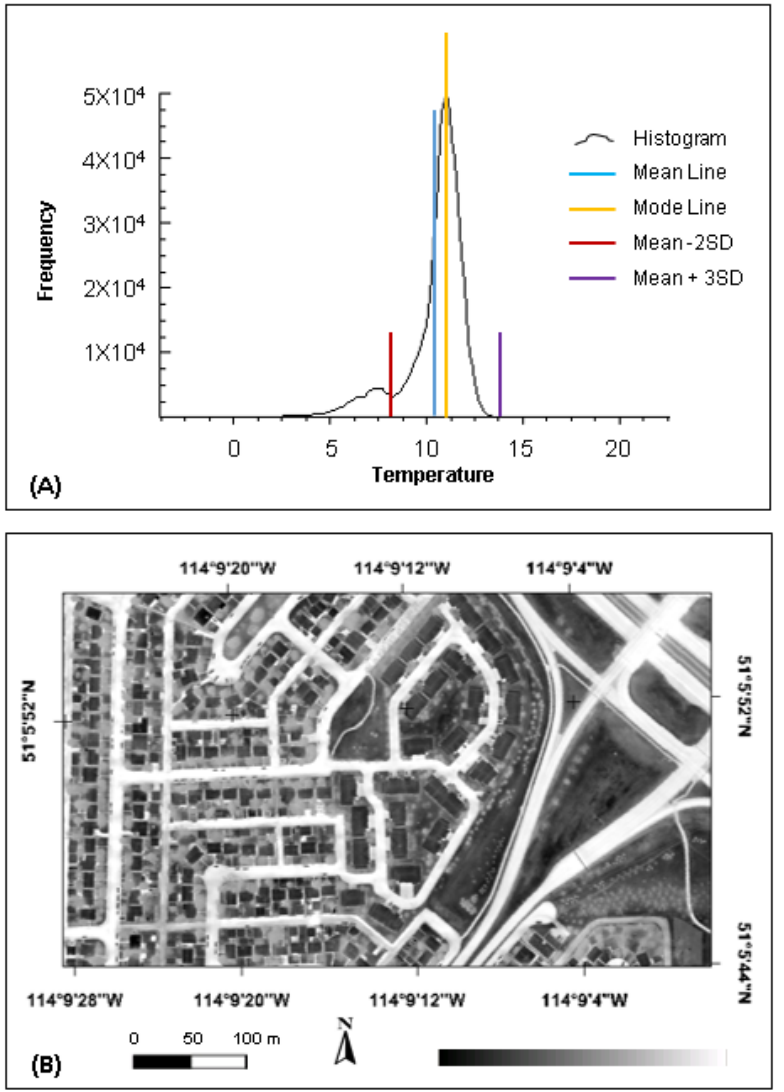
Figure 4. ( A ) Histogram of flight-line 1 showing a bimodal distribution, where the left distribution represents noise ( i.e. , road construction, vehicles, etc. ) and the right distribution represents the Road class. ( B ) A portion of the raw TIR image displaying roads, rooftops, trees, grass, parked vehicles, back alleys, etc . Dark areas are cool, bright areas are